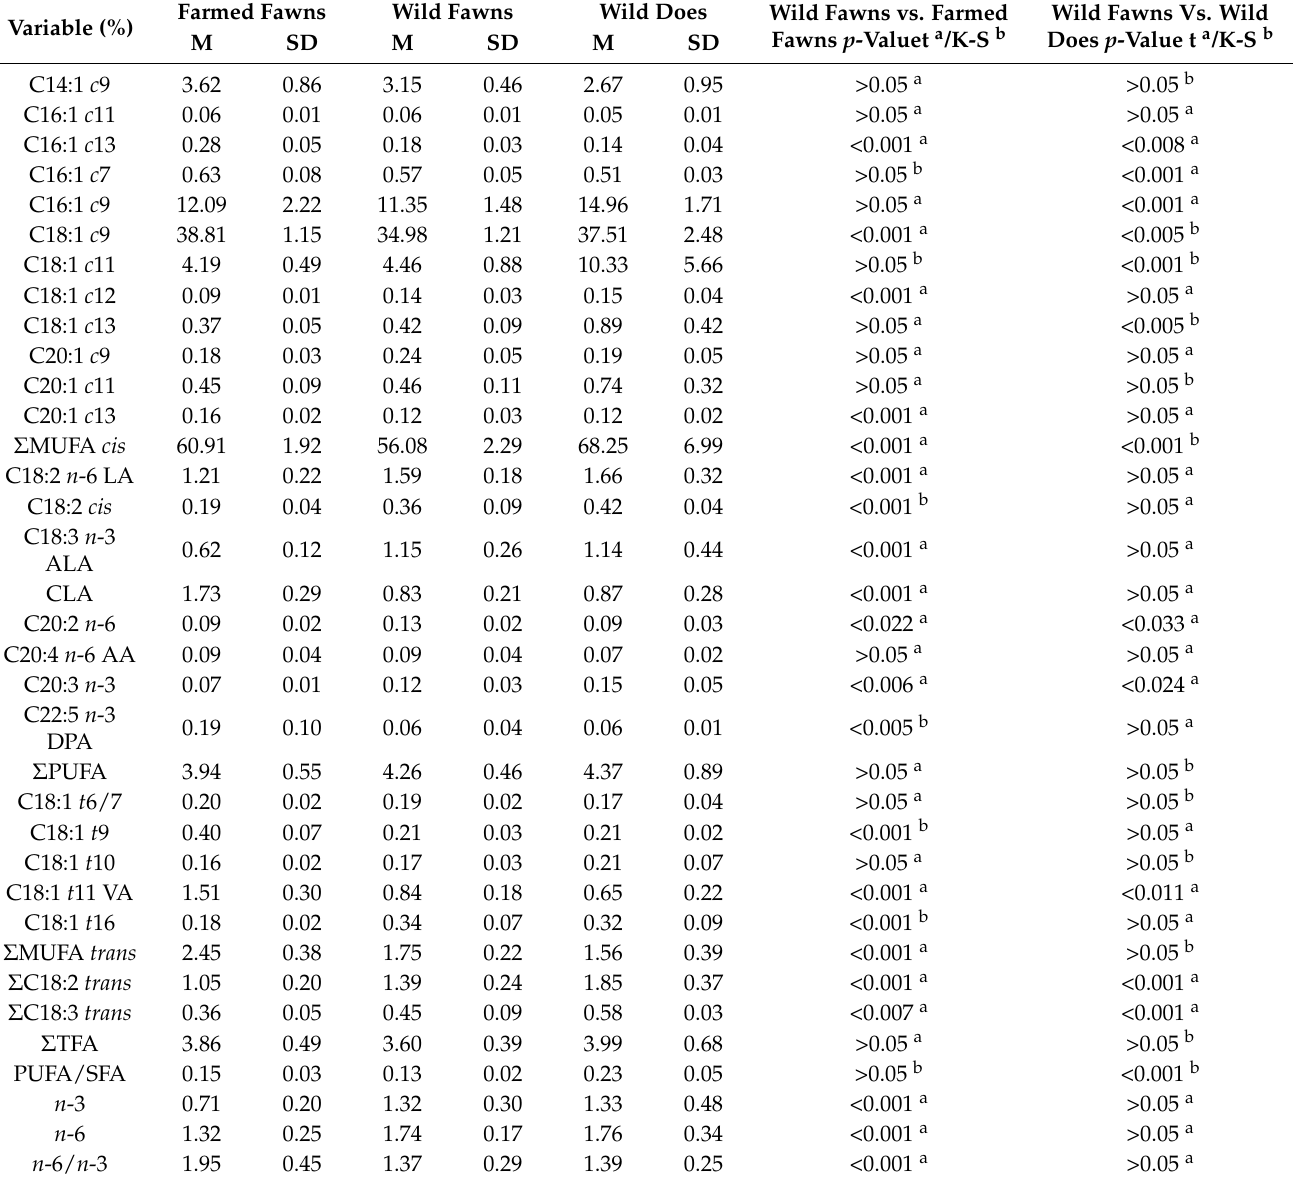
Table 3. Unsaturated and trans fatty acid composition in the bone marrow of red deer fawns and